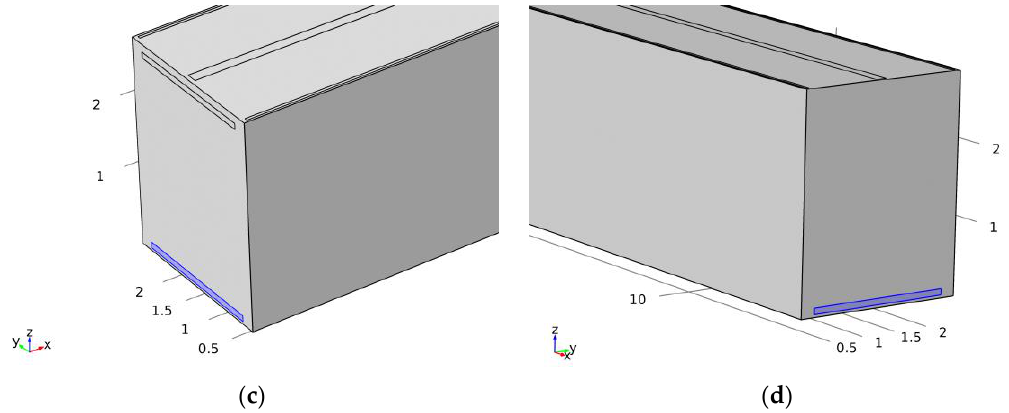
Figure 6. Location of inlets and outlets; ( a ) inlets are highlighted on the ceiling of the container, ( b ) close-up view of the inlets (highlighted), ( c ) outlet 1 (highlighted), ( d ) outlet 2 (highlighted).